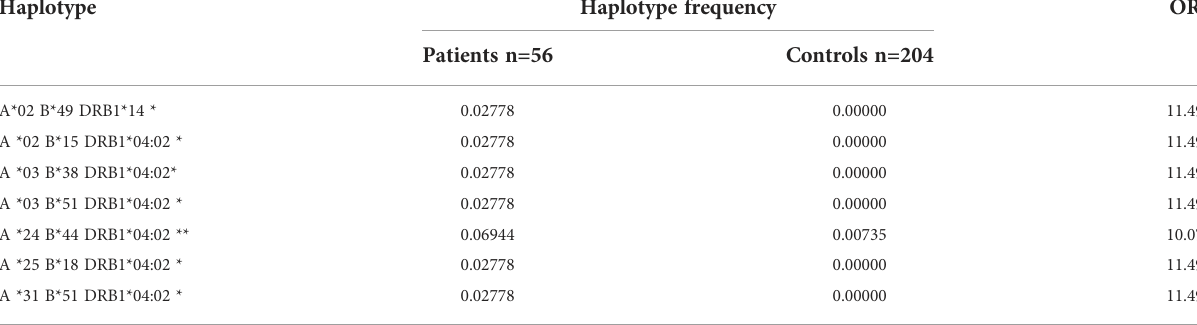
TABLE 6 HLA-A-B-DRB1 haplotypes associated with pemphigus vulgaris in the Bulgarian population.